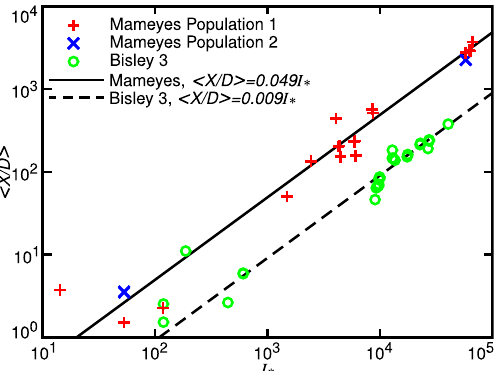
Figure 10. Mean displacement data for the first (red + ) and second (blue x) Mameyes tracers, and Bisley 3 tracers (green o). The solid and dashed black lines represent a linear relation between (cid:104) X/D (cid:105) and I ∗ for the Mameyes tracers, and the Bisley 3 tracers, respec- tively. I ∗ is calculated using U ∗ c2 .